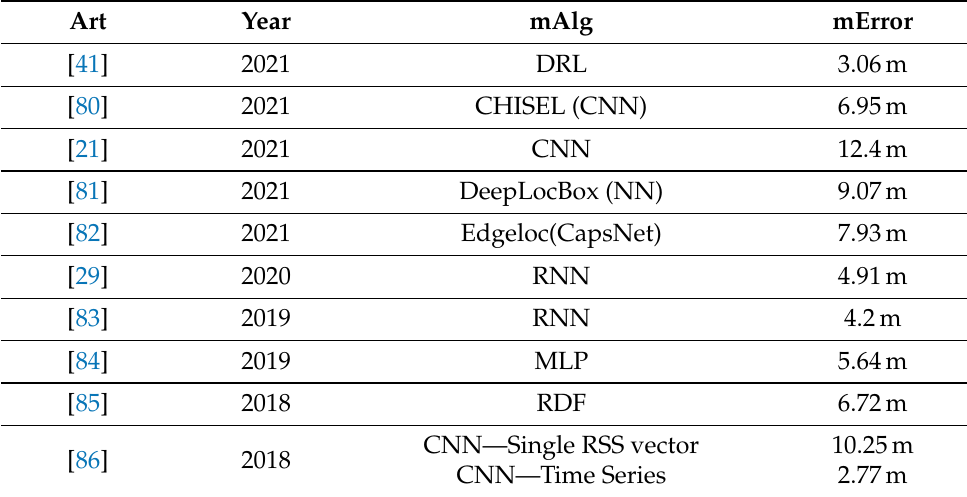
Table 2. Articles that used the UJIIndoorLoc